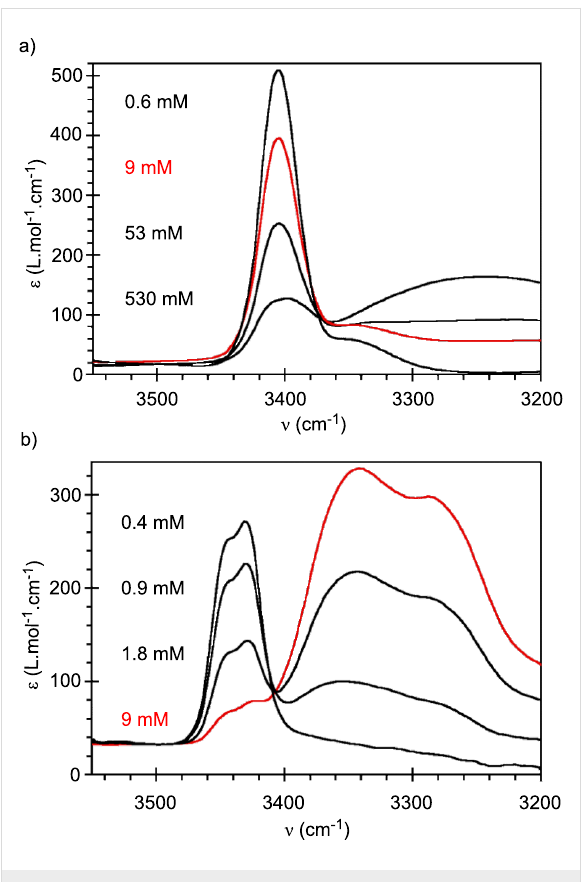
Figure 3: FTIR spectra, at 20 °C, for CDCl 3 solutions of S4 (a) or EHUT (b) , at several concentrations.